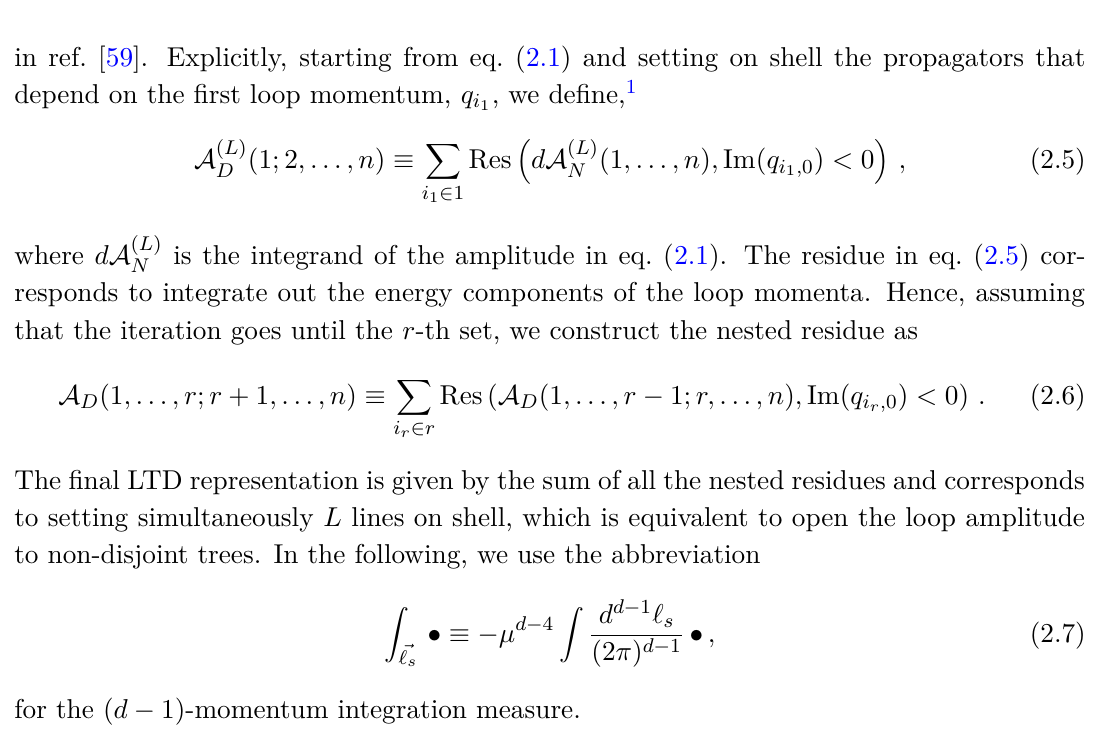
Figure 1 . Maximal Loop Topology (MLT), Next-to-Maximal Loop Topology (NMLT) and Next-to- Next-to-Maximal Loop Topology (N 2 MLT) at L loops. An arbitrary number of external momenta (not shown) is attached to the internal